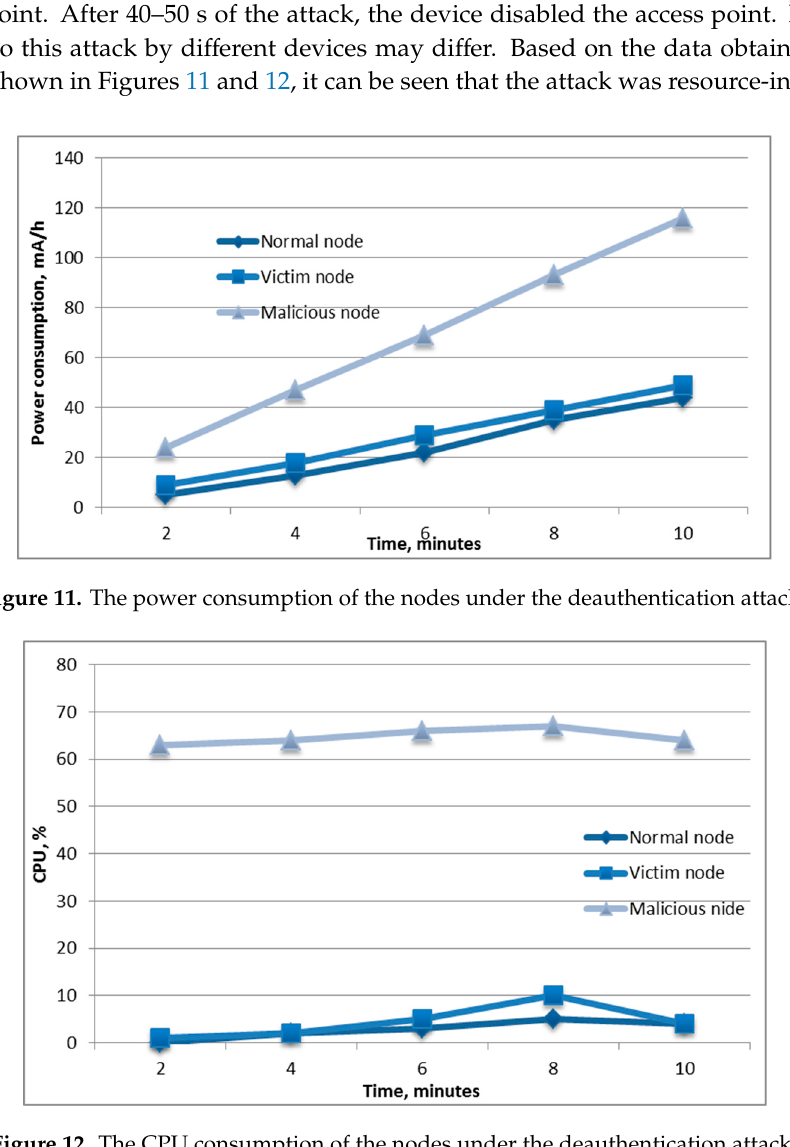
Table 3. The impact of attacks on the characteristics of the mobile device. DDoS—distributed denial of service; CPU—central processing unit; RAM—random-access memory.